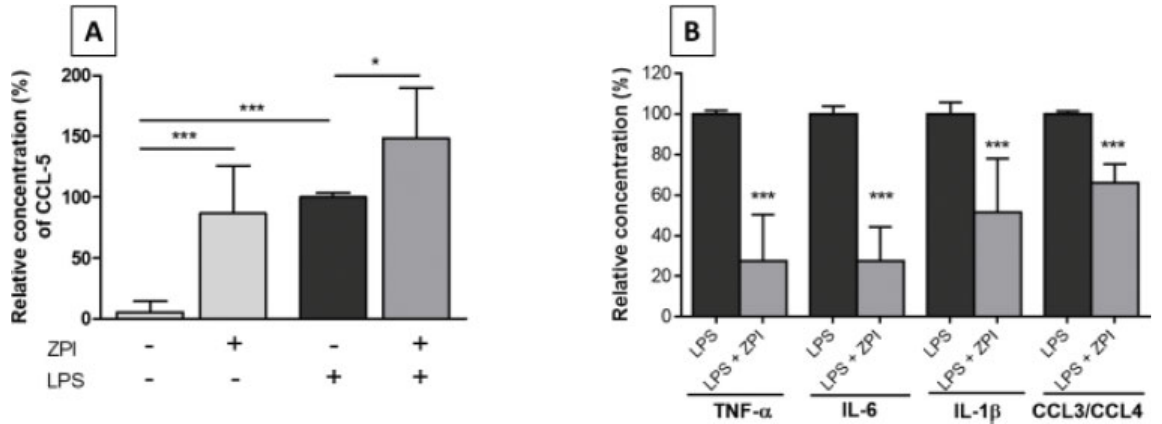
Fig. 2 Variations of the production of different in fl ammatory mediators in whole blood incubated for 4 hours in the presence of PBS (negative controls), recombinant human ZPI (rhZPI, 250 nM), lipopolysaccharide (LPS, 10 ng/mL) or both LPS and ZPI. rhZPI was added 30 min before the addition of LPS. Dots of the microarrays were integrated, according to the manufacturer ’ s instructions. Results are expressed as percentages of cytokines/chemokines induced by LPS which were considered arbitrarily as 100%. Results (mean (cid:4) 1 SEM) are the average of 3